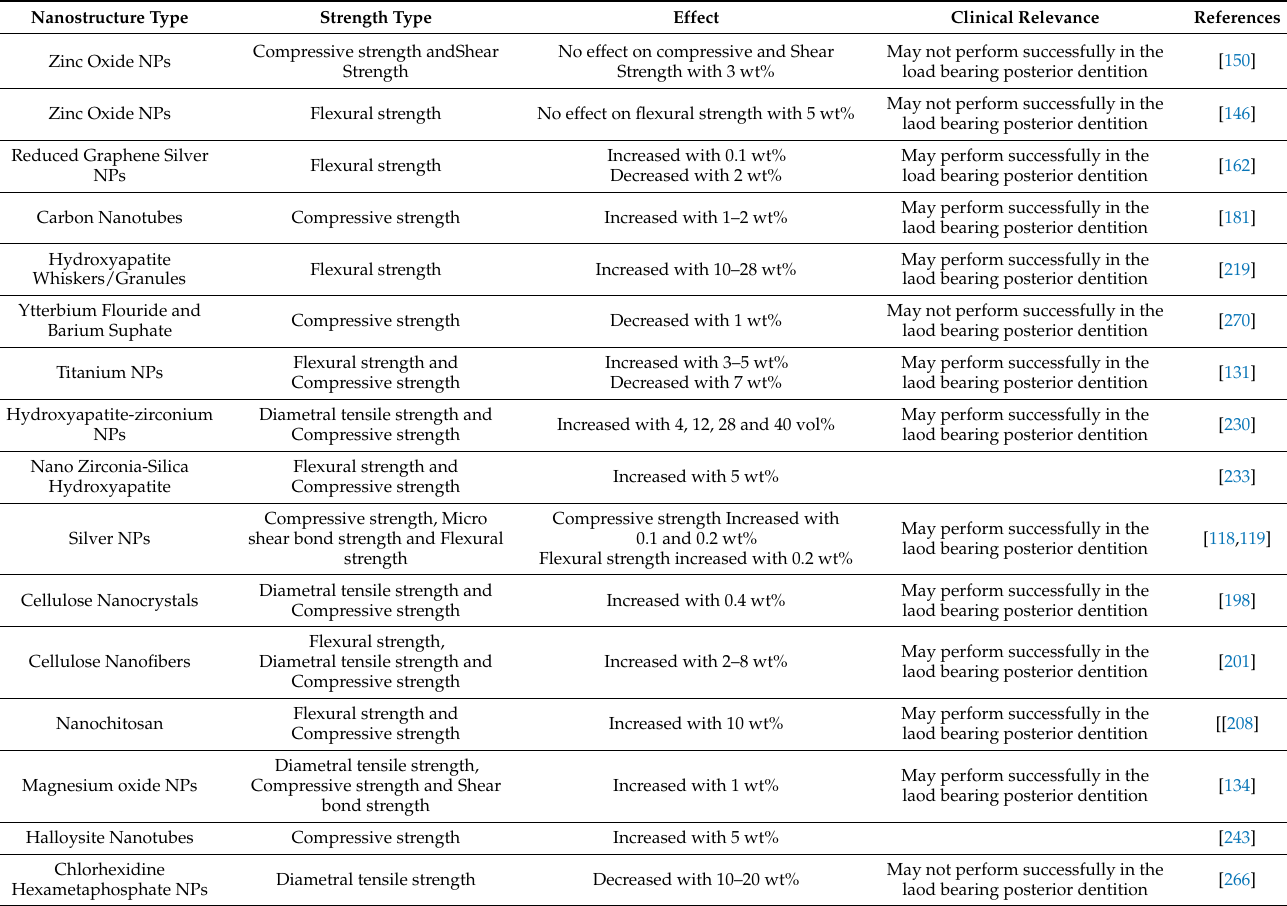
Table 3. Effect of the incorporation of various nanostructures on the mechanical strength of